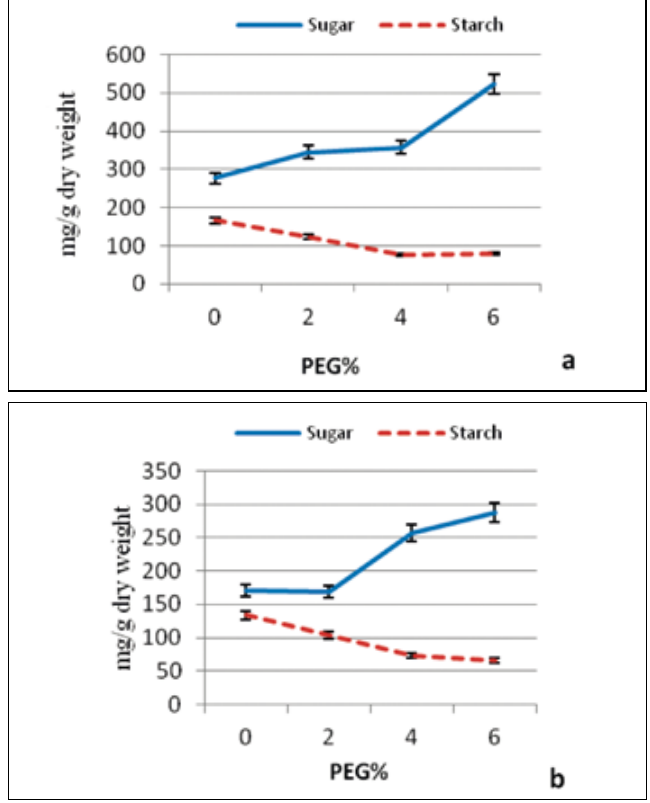
Fig. 3 - Changes in leaf sugar and starch content in two fig cultivars: ‘Sabz’ (a) and ‘Siah’